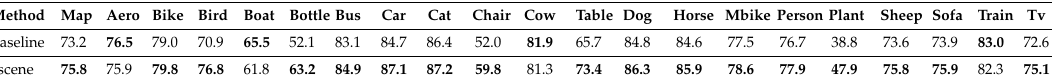
Table 5. Ablation study on PASCAL VOC 2007 test. All methods are trained on PASCAL VOC 2007trainval + 2012trainval. Baseline: faster region-based convolutional network (faster R-CNN). Scene: only using scene information. The bold characters represent the best result for each